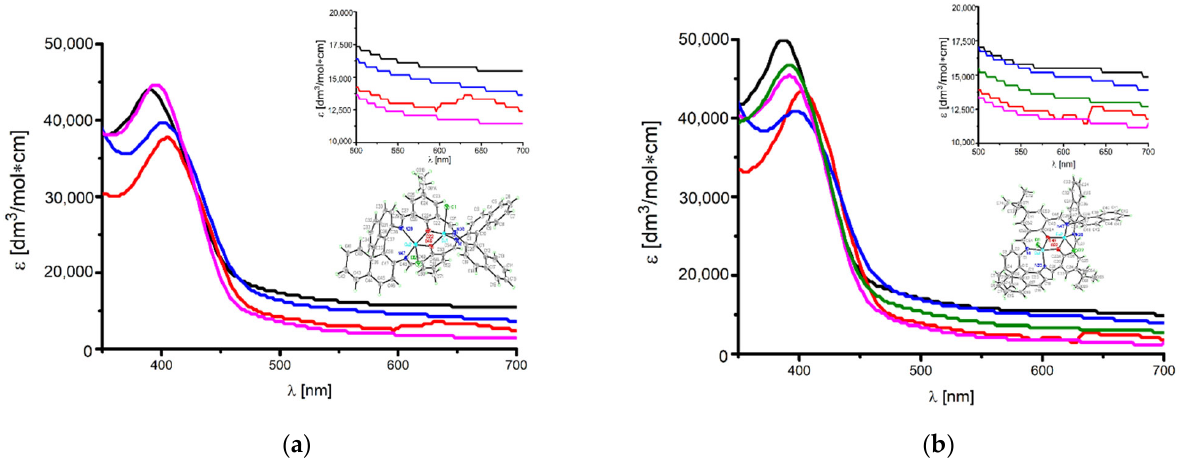
Figure 8. Absorption spectra ( a ) of K1 and ( b ) K2 complexes in solvents: chloroform (red), acetone (blue), methanol (black), acetonitrile (green), and DMSO (purple) (3.323 × 10 − 6 mol/dm 3 , RT).